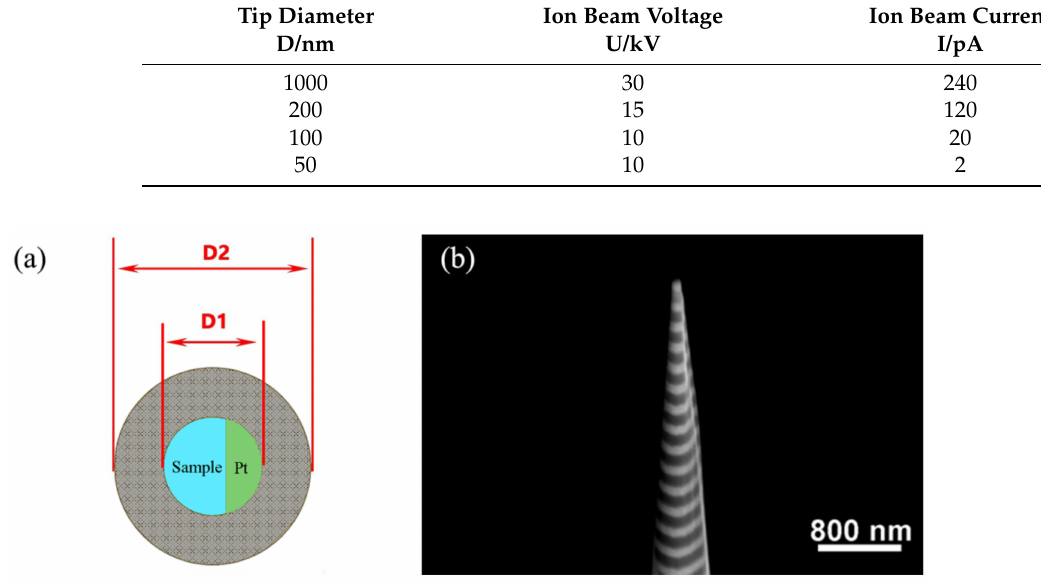
Figure 8. Example of annular milling and the APT specimen tip shape of the Al/Ni multilayers.